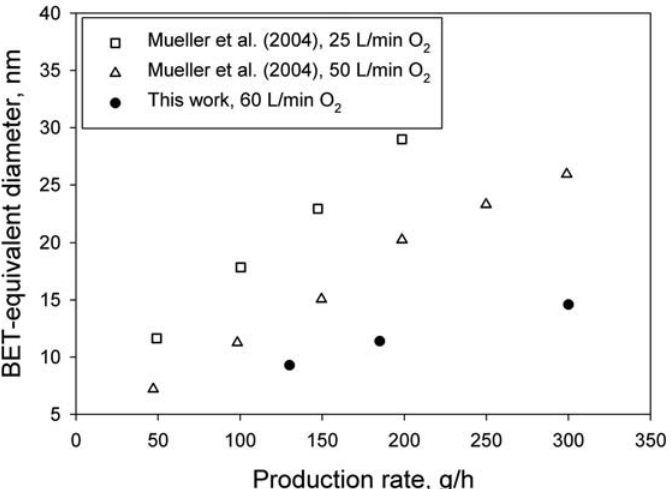
nanoparticles as a function of the powder production rate for disper- Fig. 2 BET-equivalent diameter of FSP-made ZrO 2 sion gas flows of 25 and 50 l/min (Mueller et al., 2004b)) and 60 l/min (this work). Increasing the production rate by higher flows of the precursor solution at a constant 0.5 mol/l Zr concentration increases the primary product particle